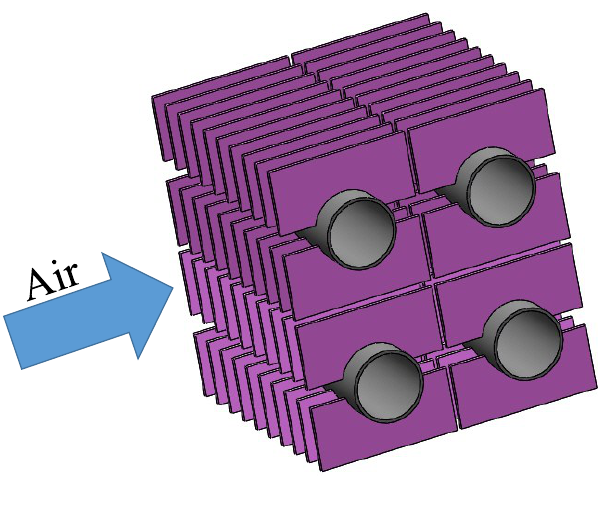
Figure 2. Schematic diagram of the test